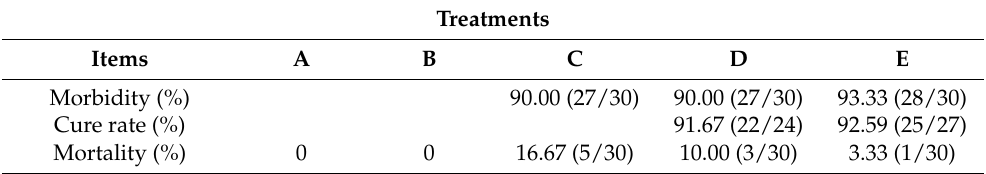
Table 2. Morbidity of CRD, cure rate and mortality of broilers between different treatment groups. Treatments